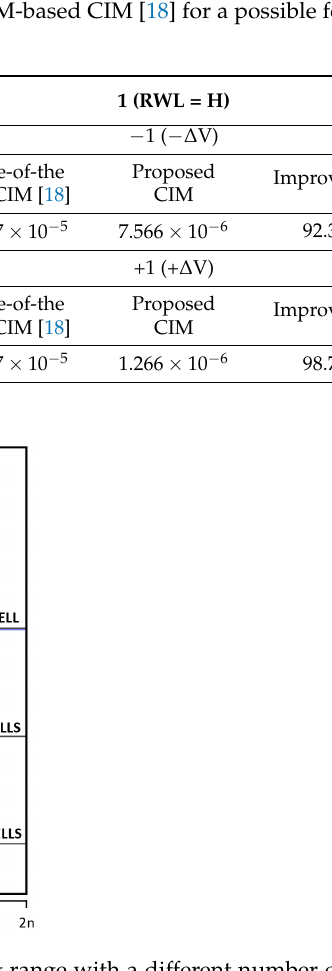
Figure 8. Comparison of read bitline (RBL) discharging range with a different number of SRAM bitcells (1 cell–3 cells).